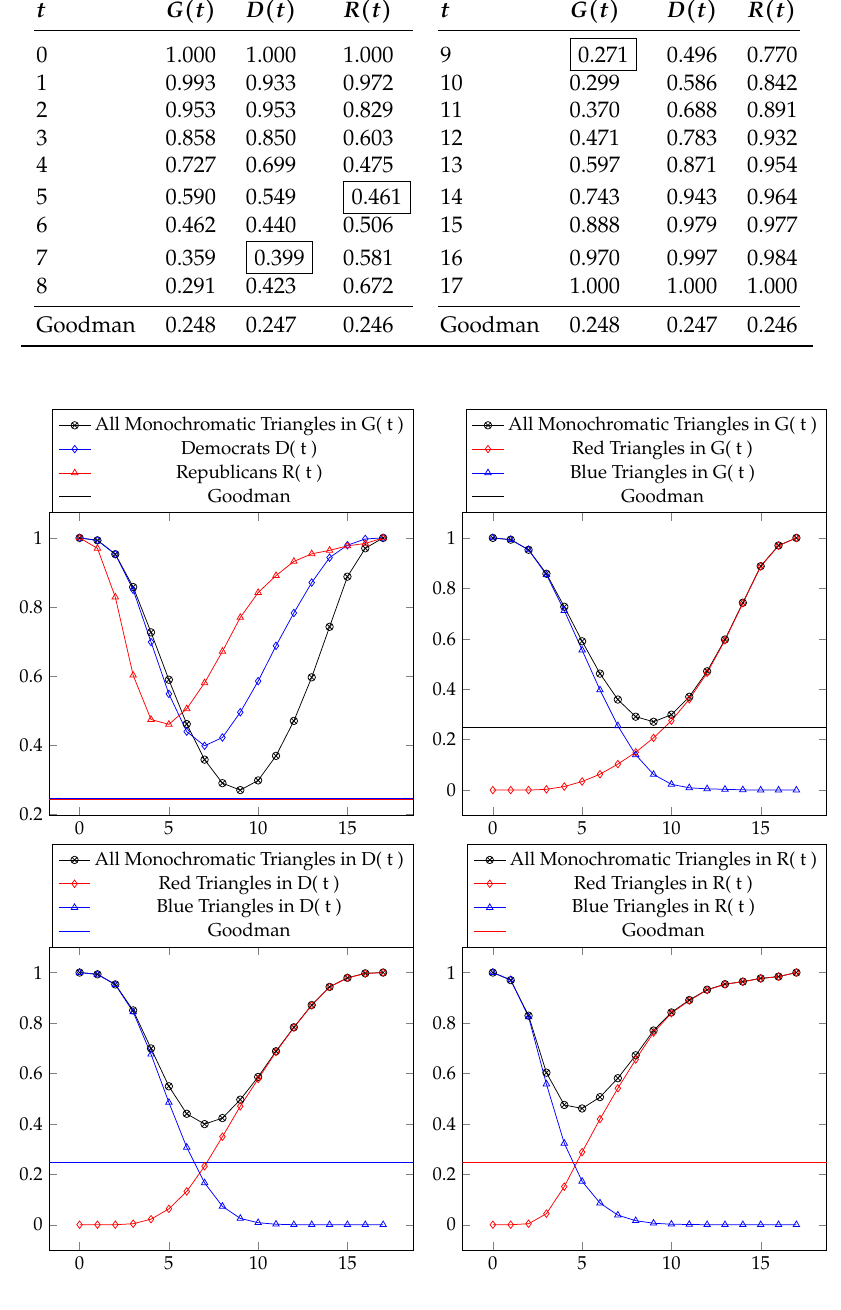
Figure 5. Data from Table 2